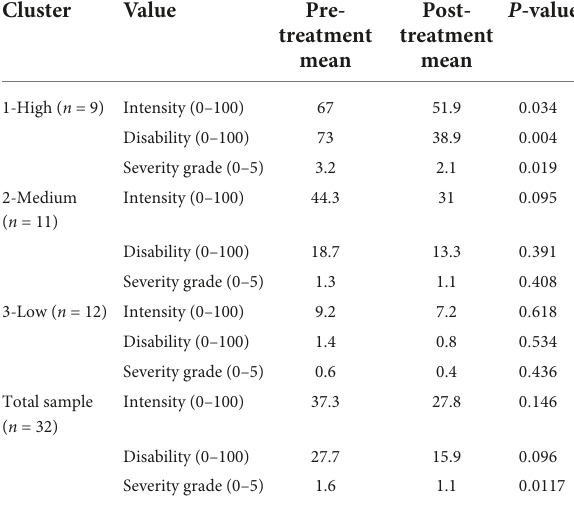
TABLE 4 Bivariate pre-treatment and post-treatment mean and p -values using t -testing for CPG pain intensity , disability score and